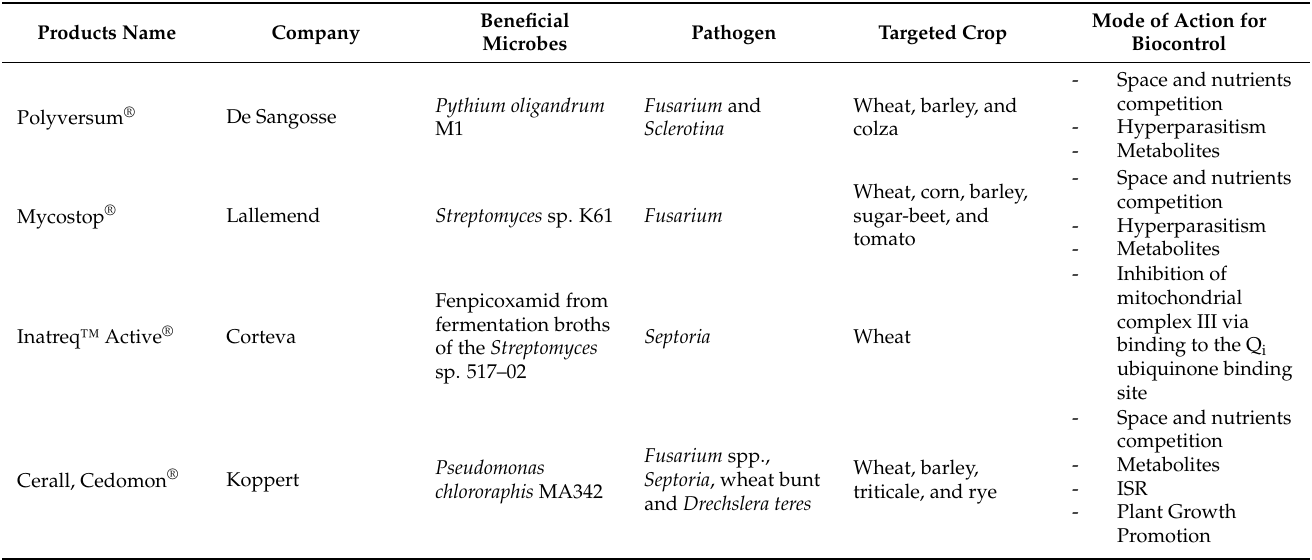
Table 1. Commercial bacterium-based products against barley and wheat